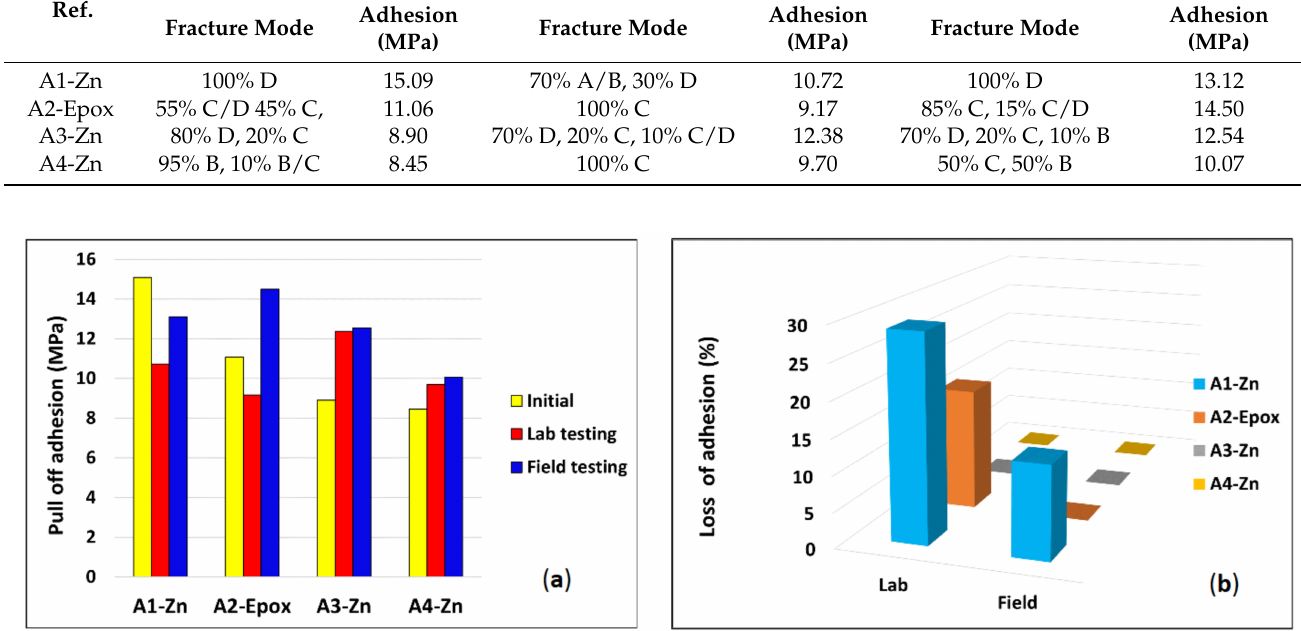
Figure 4. ( a ) Pull-off adhesion strength of the coatings for the atmospheric zone before and after aging and field exposure. ( b ) Loss of adhesion of the coating systems after aging and field